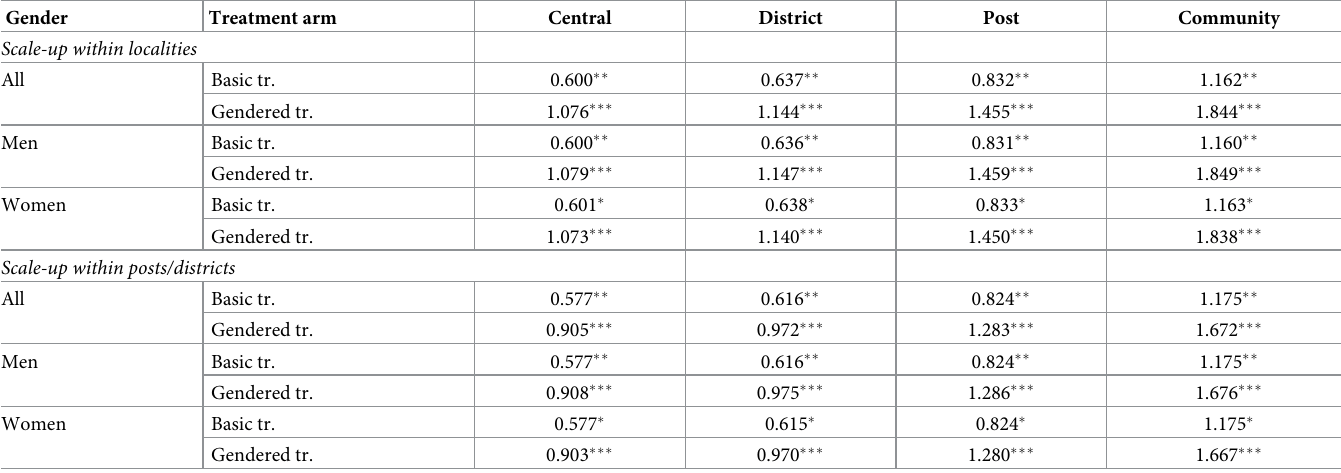
Table 10. CGAAS: CERs under scale-up scenarios as a share of CERs of original